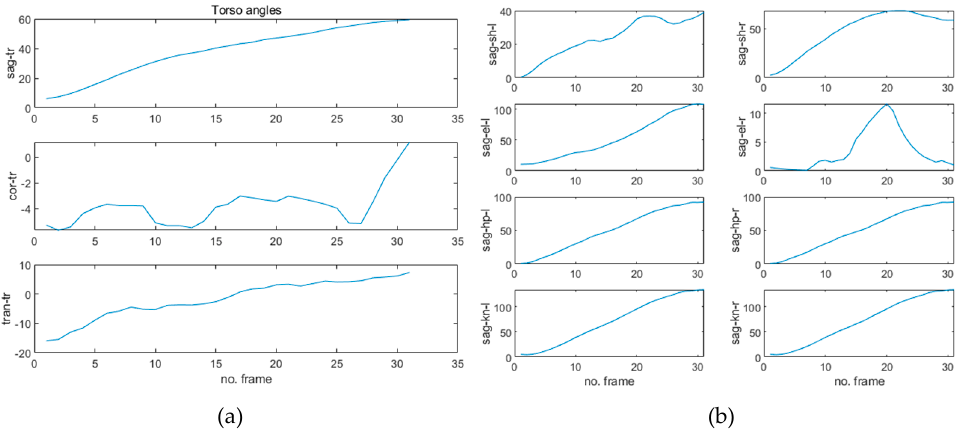
Figure 12. Trajectories of the estimated joint angles (degree) at ( a ) the torso and ( b ) the sagittal plane.